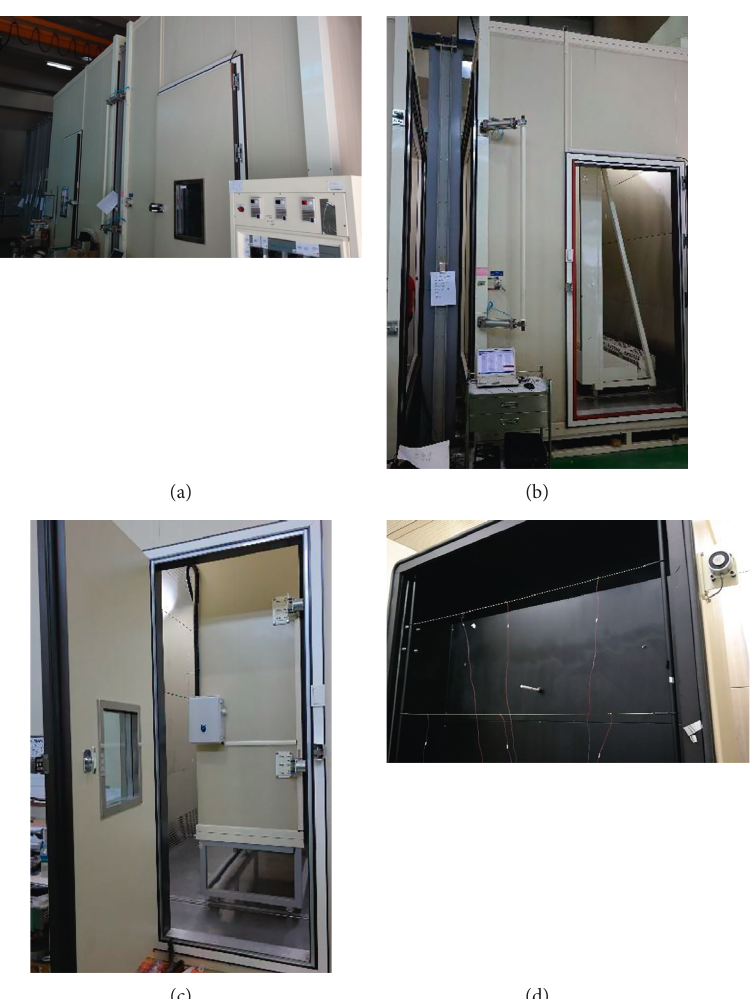
Figure 2: (a) Test equipment for thermal transmittance, (b) cold chamber of test equipment, (c) hot chamber of test equipment, and (d) hot box in hot chamber of test